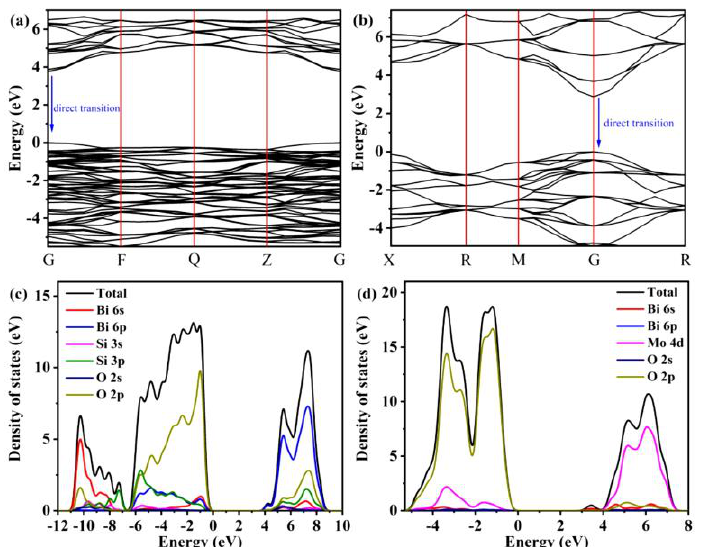
Figure 7. Energy band structures of Bi 2 SiO 5 ( a ) and Bi 4 MoO 9 ( b ). Density of states of Bi 2 SiO 5 ( c ) and Bi 4 MoO 9 ( d ). Reproduced with permission from [107]. Copyright 2020 under Creative Commons Attribution (CC-BY) Licence.